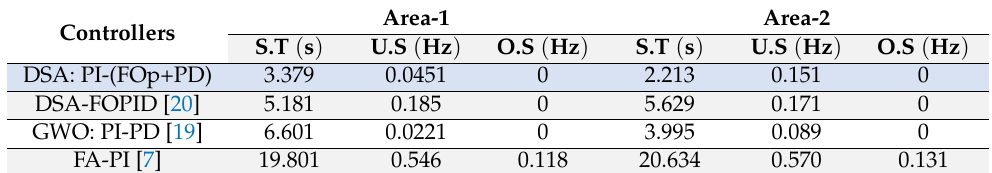
Table 5. Communication delay performance of controllers in Area-1 and Area-2 at 7% load change.